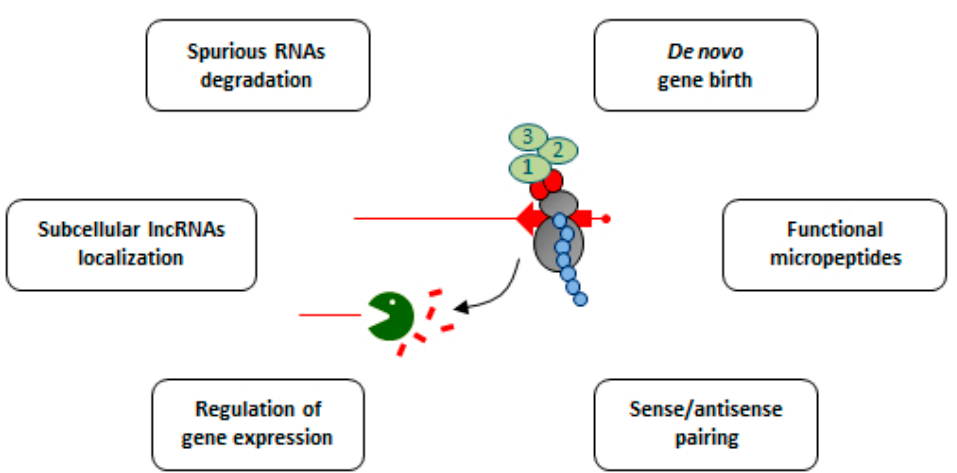
Figure 4. Possible roles of translation and NMD in the metabolism of (as)lncRNAs. Schematic representation of the functional importance of NMD and translation in lncRNAs metabolism (see main text for details). The chain of blue balls represents the micropeptide produced upon the translation of the smORF (red arrow) of the (as)lncRNA. The ribosome, the (as)lncRNA and the NMD/decay factors are represented as above.